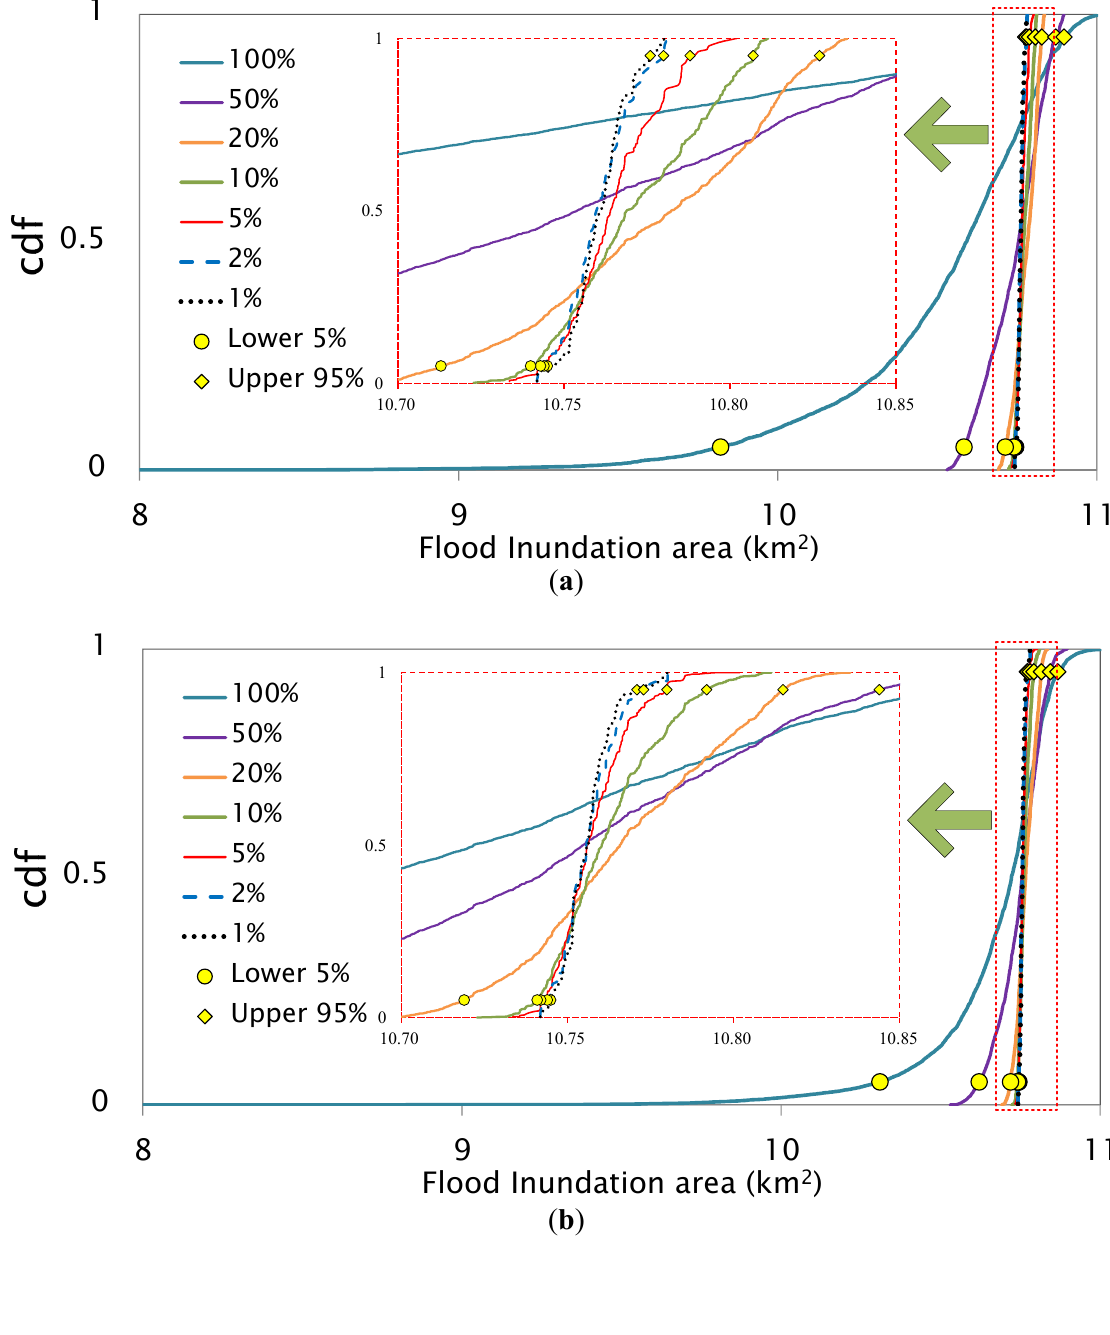
Figure 7. Comparison of the generalized likelihood uncertainty estimation (GLUE)